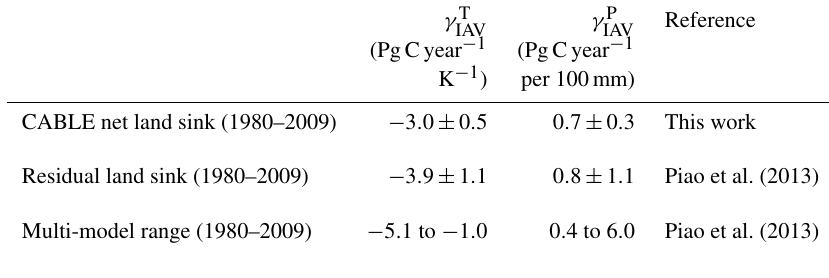
Table 5. Interannual global carbon–climate sensitivities, as defined by Eq.